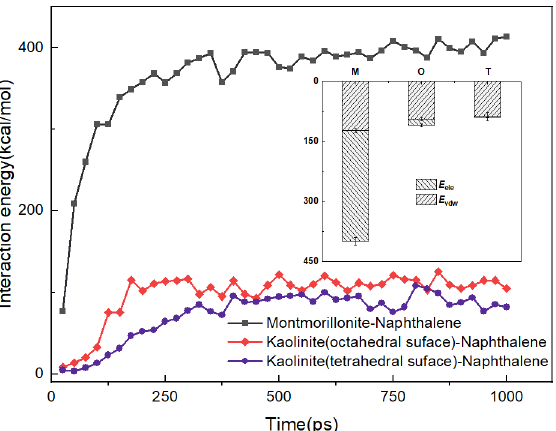
Figure 3. The interaction energies between montmorillonite and kaolinite surfaces and the naphtha- lene molecules in relation to the change in simulation time.